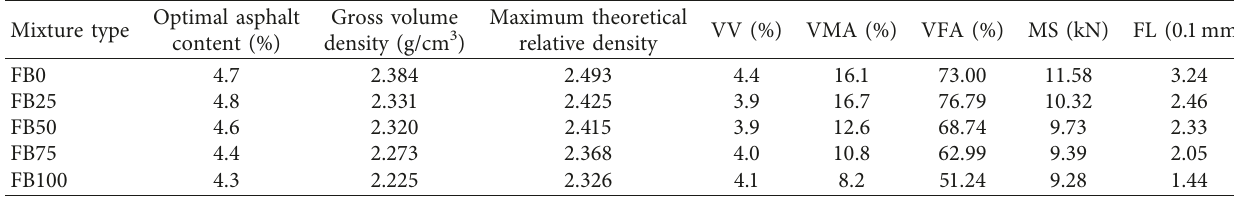
Table 5: Results of the mixture with different FB proportions.